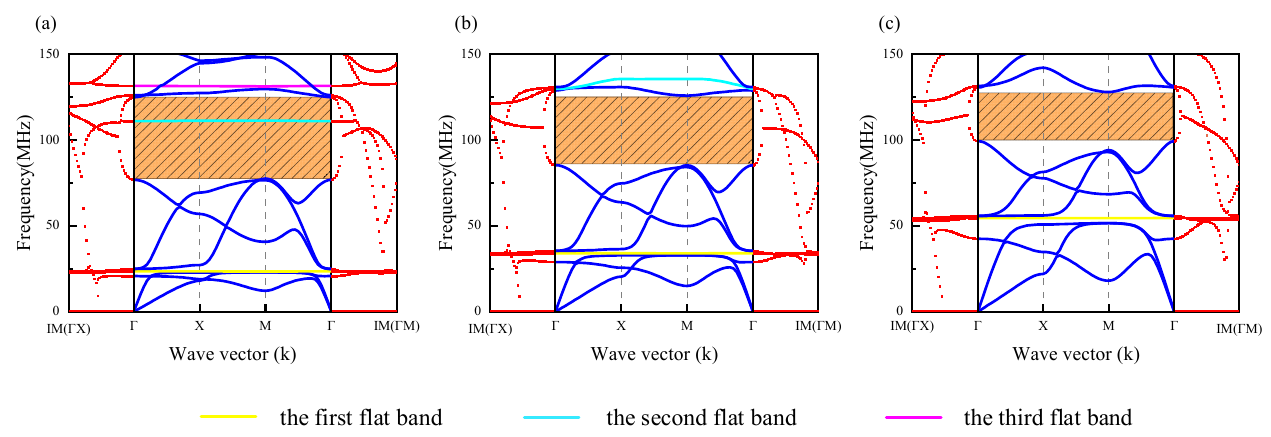
Figure 7. Complex energy band curve with different hole widths, The blue solid line represents the real wave vector energy band curve, and the red dotted line represents the imaginary wave vector attenuation curve. ( a ) 𝑐 = 1 µm , ( b ) 𝑐 = 3 µm , and ( c ) 𝑐 = 5 µm . It can be seen from Figure 7 that when 𝑐 = 1 µm , the second band gap of the DIH- PnC structure was 77.6–125.1 MHz. When 𝑐 = 3 µm , the second band gap of the DIH-PnC structure: 85.3–125.0 MHz. When 𝑐 = 5 µm , the second band gap of the DIH-PnC struc- ture: 94.1–128 MHz.